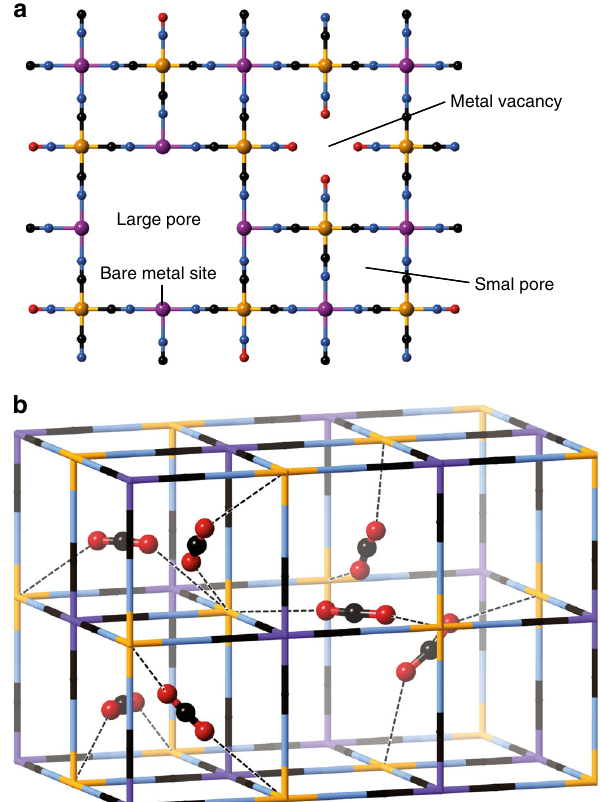
Fig. 1 Visual representations of Prussian blue-type frameworks. a Network of a defective TMNP framework illustrating the different pore types. The large pore arises from vacancies of the Fe(CN) 5 NO unit in TMNPs or of the M ′ (CN) 6 unit in PBAs. The metal vacancy pore arises from the presence of non-bridging NO ligands in TMNPs and does not occur in hexacyanidometallate PBAs. Note that, while they are shown as separate here, the vacancy pores may border upon or overlap with others of the same or different type. b Fragment of the FeCo-PB structure containing its theoretical maximum CO 2 content of one “ Site A ” CO 2 molecule in each of the four small pores and three “ Site B ” molecules in the large pore. Dashed lines indicate interactions between CO 2 and the Fe sites. The host and guest atomic positions were previously determined by NPD 37 . Colours: Fe (orange); Co (purple); C (black); N (blue); O exhibited by the TMNP Co[Fe(CN) 5 NO] (hereafter Co-NP) and the PBA Fe 3 [Co(CN) 6 ] 2 (hereafter FeCo-PB). A simple empirical model for the modifying effects of guest concentration on the